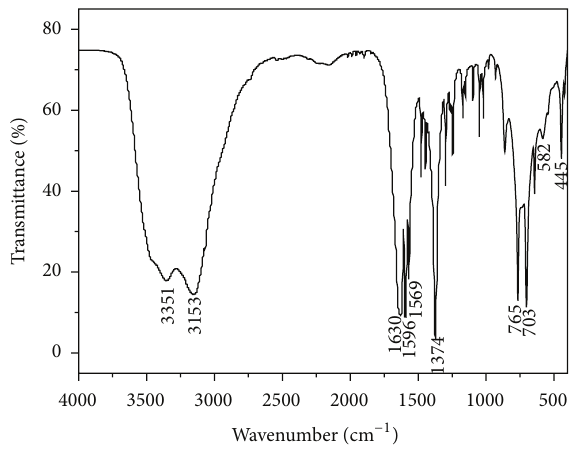
Figure 7: FT-IR spectra of the title